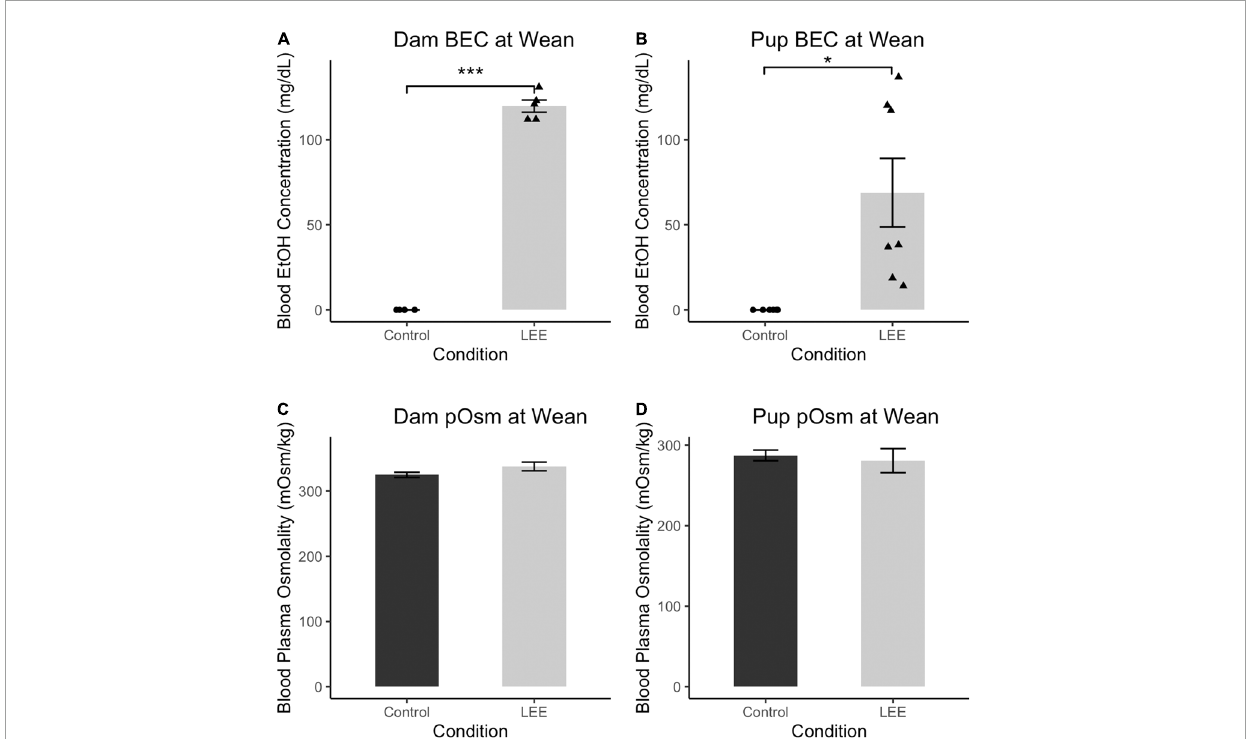
FIGURE2 Blood ethanol concentration and pOsm measurements. (A) BEC measurements in Control and LEE dams at wean after a 14 day exposure to water (control) or 25% EtOH. LEE mice exposed to 25% EtOH had an average BEC of 119.8 mg/dL compared to controls which had a BEC of 0 mg/dL ( N = 10). (B) BEC measurements in Control and LEE pups at wean after dams were exposed to water or 25% EtOH for 15 days. LEE pups had greater BECs (68.9 mg/dL on average) compared to controls at 0.0 mg/dL ( N = 14). (C) No significant differences observed between control ( M = 324.8 mOsm/kg, SD = 8.8 mOsm/kg) and LEE ( M = 337.7 mOsm/kg, SD = 16.3 mOsm/kg) dam plasma osmolality (pOsm) at wean ( N = 11). (D) No significant differences in pup pOsm at wean between control ( M = 287.1 mOsm/kg, SD = 20.0 mOsm/kg) and LEE ( M = 280.6 mOsm/kg) offspring ( N = 16; * p < 0.05, *** p < 0.001). (A,B) Triangles represent individual data points taken for each experimental condition. Data expressed as mean ±